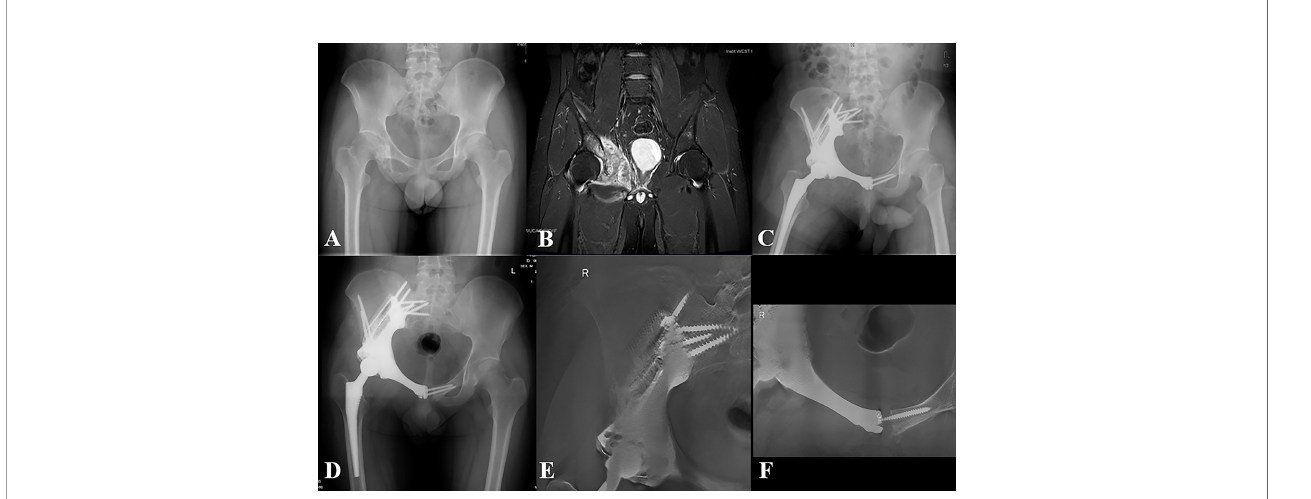
FIGURE 4 | Representative case of the MGMII group. (A) Preoperative X-ray of the pelvis of patient 16. (B) Preoperative MRI of the pelvis. (C) X-ray of the pelvis taken at 3 days after surgery. (D) X-ray of the pelvis taken at 10 months after surgery. (E, F) T-SMART taken at 10 months after surgery showed excellent osseointegration.